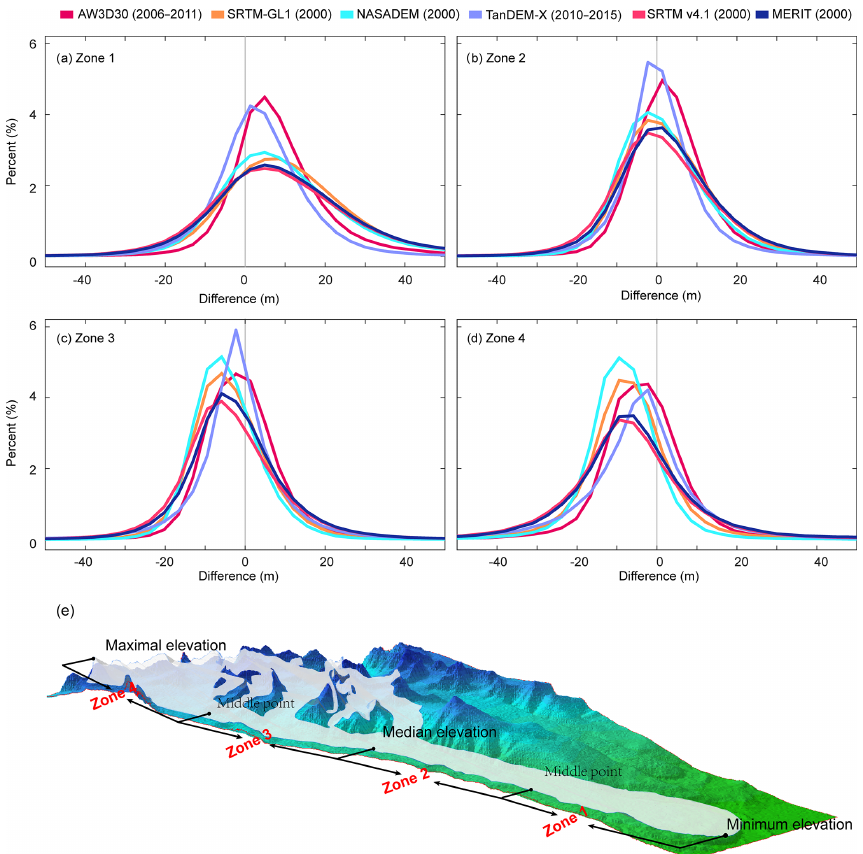
Figure 7. Probability distribution of the difference between six DEMs elevation and ICESat-2 elevation in different glacier zones (a–d) as defined in panel (e) . The acquisition date of each DEM is